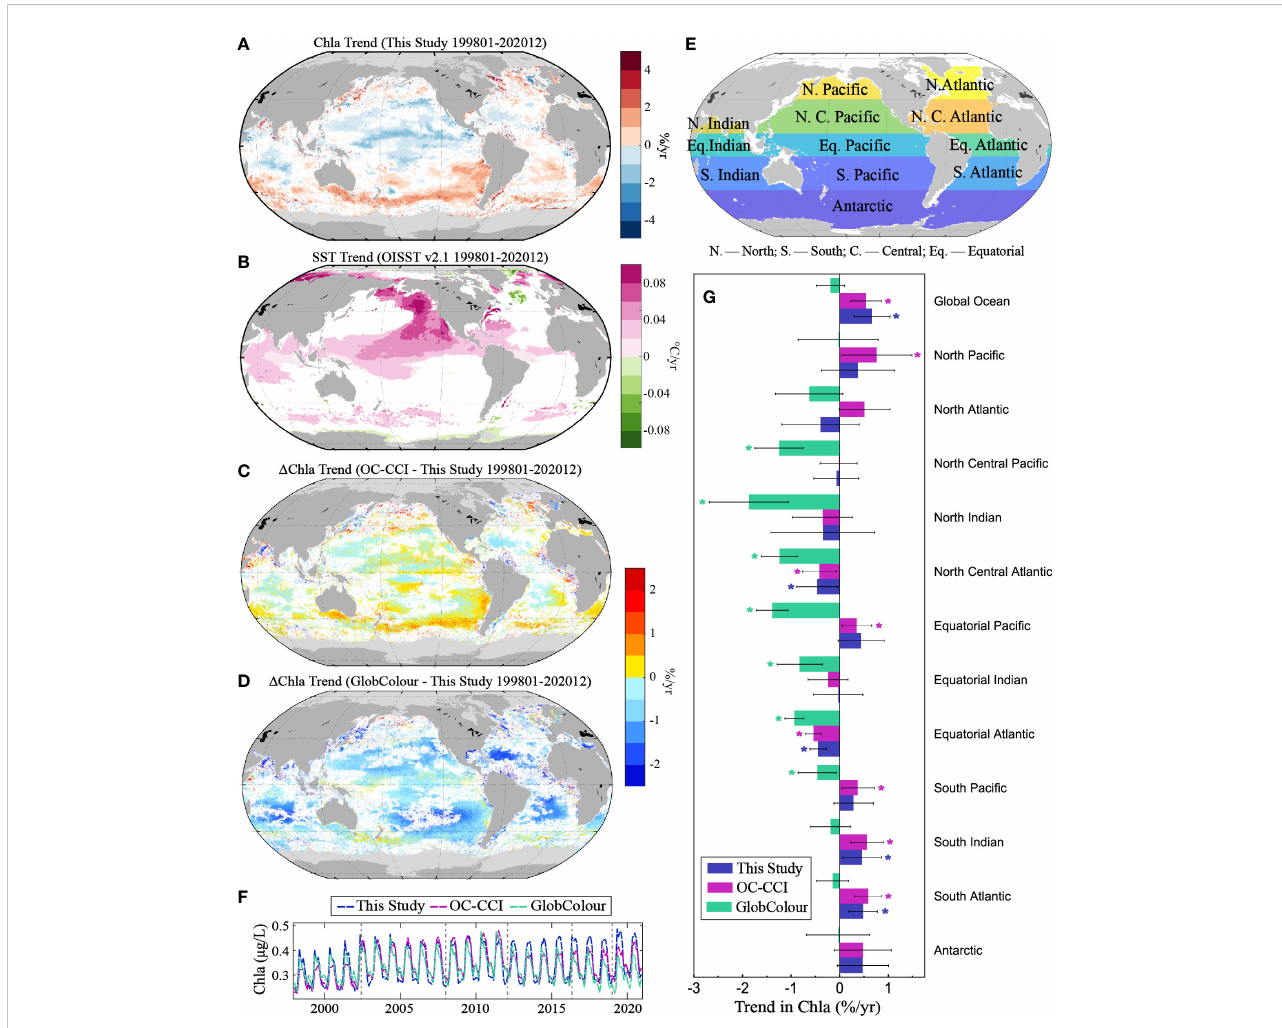
FIGURE 8 (A) Chla trend map derived from this study and (B) SST trend map from 1998 to 2020. (C, D) Trend differences between OC-CCI and GlobColour and that from this study in units of %/yr. (E) Basin de fi nitions for the trend analysis (Gregg and Rousseaux, 2014), (F) time series curve of global Chla, and (G) Chla trends in global oceans and 14 basins from the three merged datasets. The light gray on the maps represents insuf fi cient data from our dataset for making a trend calculation (i.e., the number of valid data collected in the statistical period (138 months) does not reach 50%), and white indicates that the pixel trend is insigni fi cant ( p > 0.05) according to our dataset. For (G) , the bar with an asterisk (*) marked indicates that the trend is signi fi cant ( p < 0.05); error bars show 95% credible intervals of the rate of